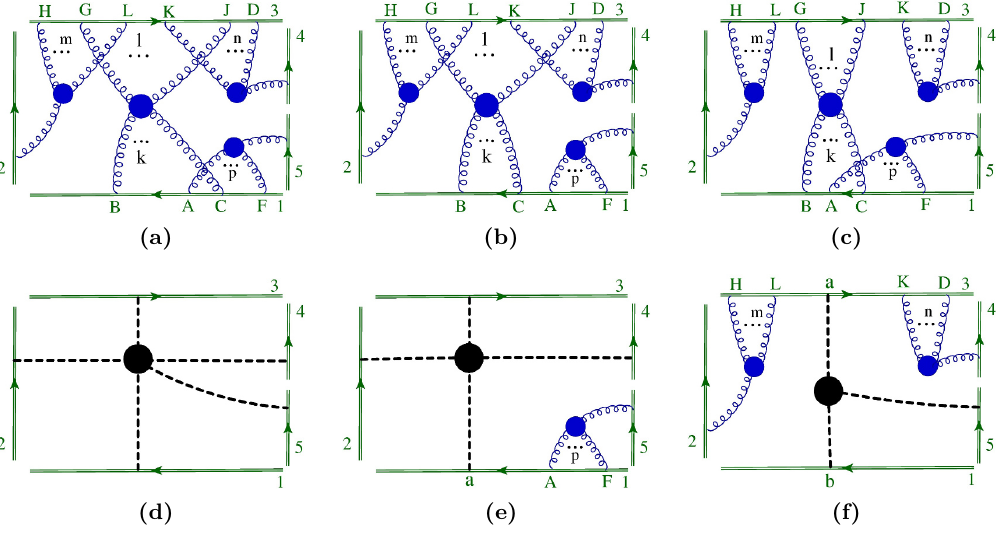
(1 , 1 , 1 , k + p, m + l + n ) 5